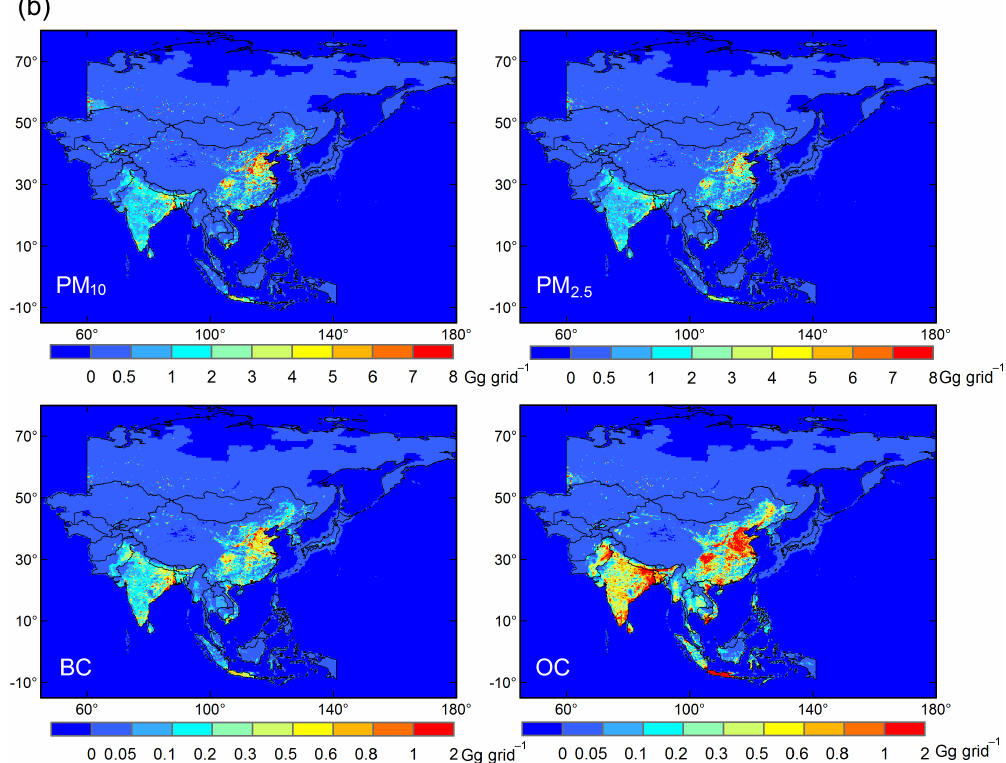
Figure 12. Grid maps for gaseous (a) and aerosol (b) species in the MIX Asian emission inventory,